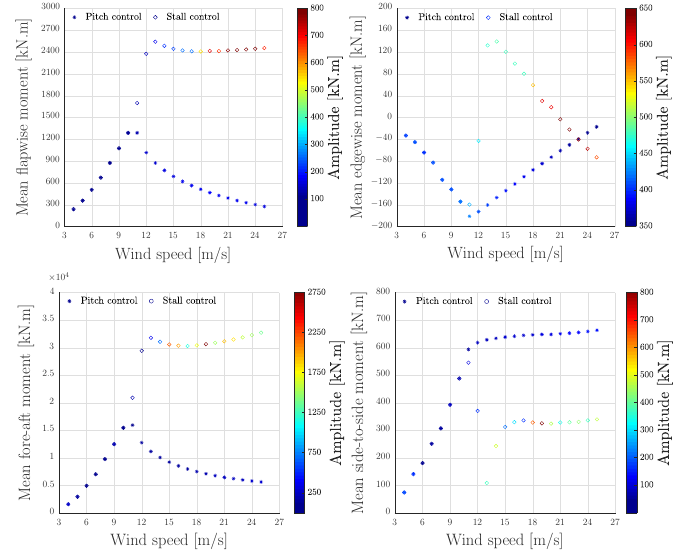
Figure 17. Comparison of the fatigue loads on the structure of the WP wind turbine operating with pitch-to-stall and pitch-to-feather control in the whole wind speed